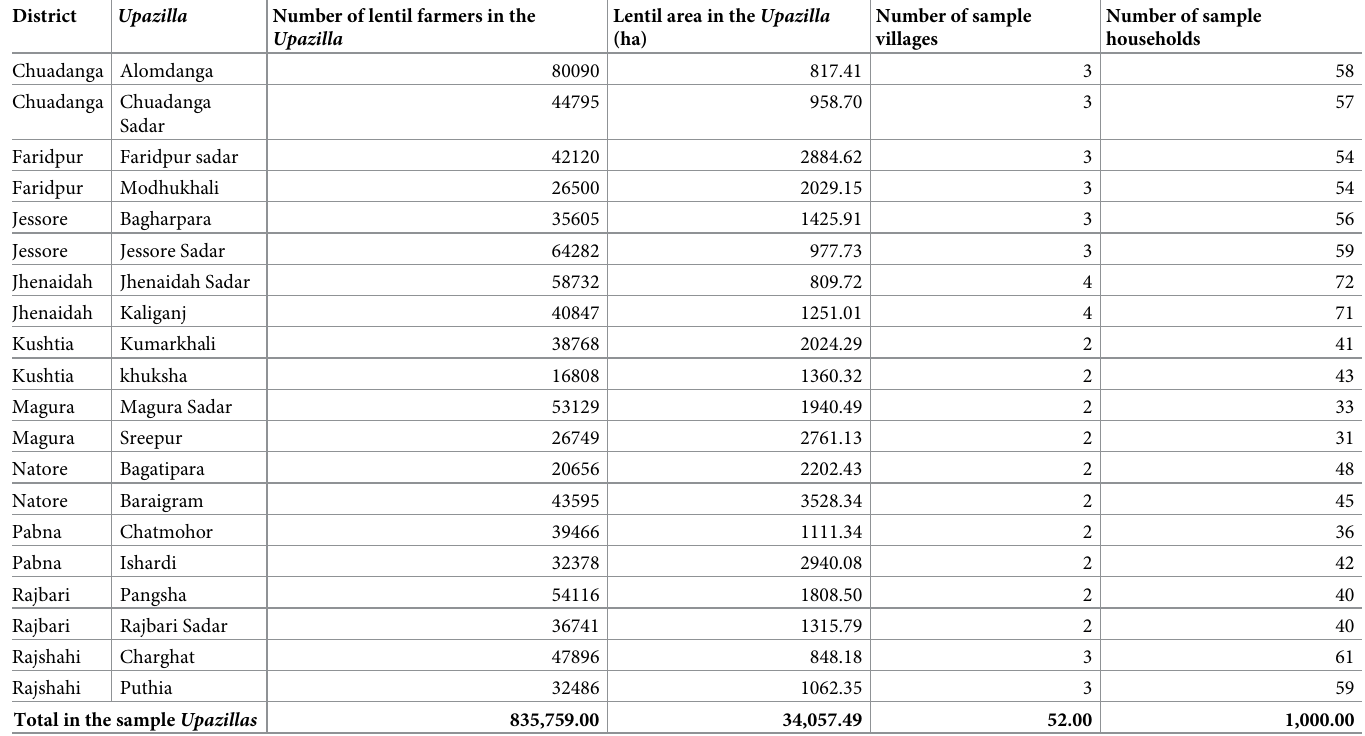
Table 2. Distribution of samples across Western